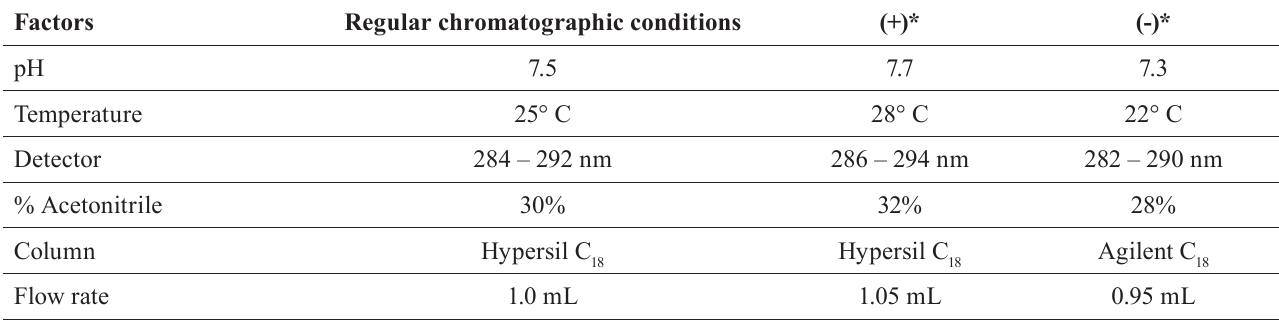
TABLE II - Deliberately made changes to the chromatographic conditions following Plackett-Burman factorial